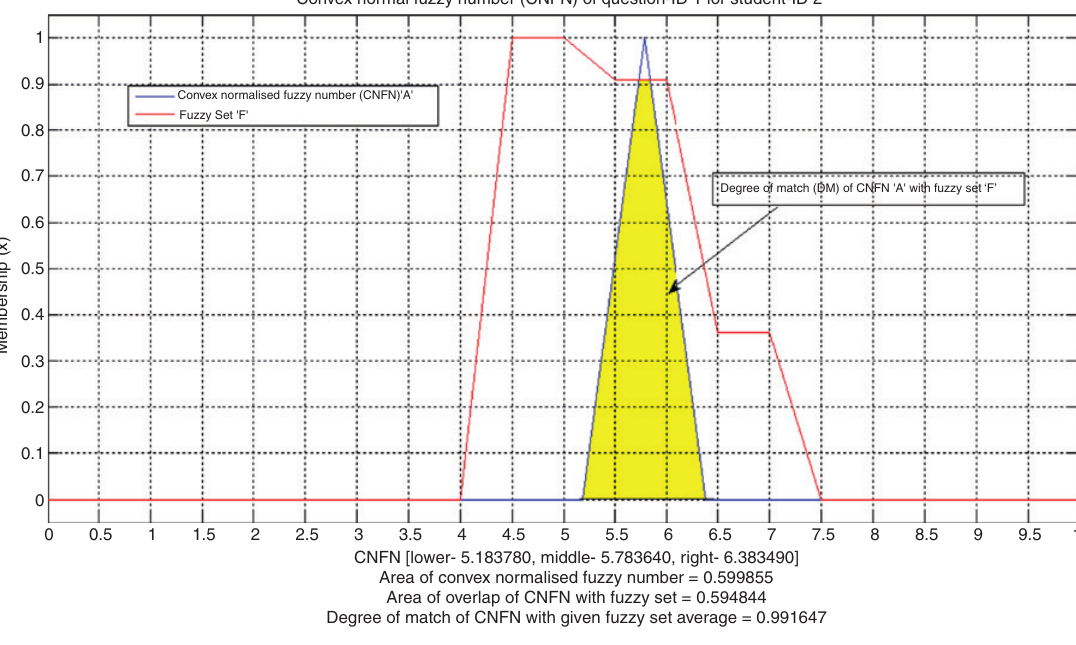
Figure 3: DM between CNFN “A” (Question 1 Marks) and Fuzzy set “F” (Average